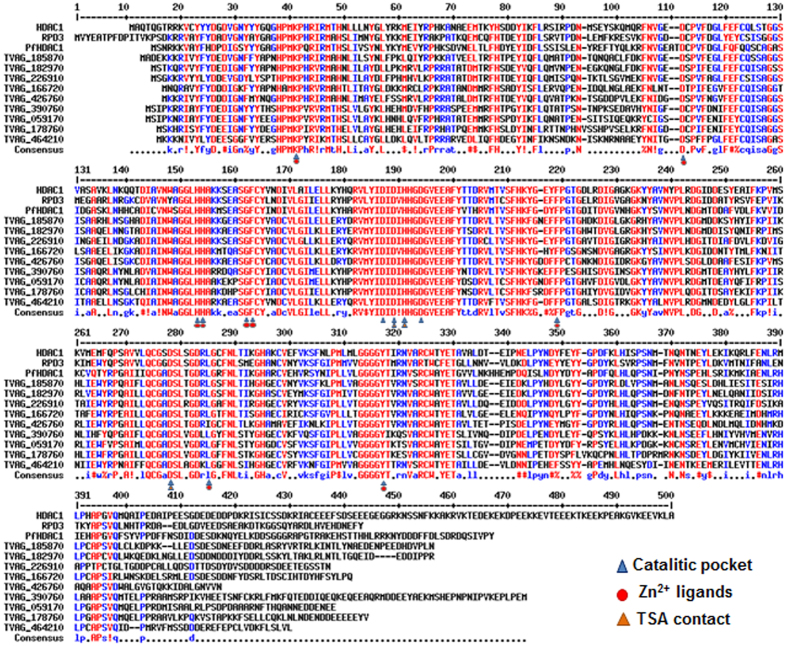
Histone deacetylase enzymes in T. vaginalis.Multiple protein sequence alignment of T. vaginalis HDACs with select orthologues. Indicated are residues important for catalytic activity and involved in zinc and TSA binding, based on the crystal structure of related HDACs2425. Alignments were performed with Multalin (http://bioinfo.genotoul.fr/multalin/). Gene bank accession numbers: human HDAC1 (NP_004955), Saccharomyces cerevisiae Rpd3 (AAB20328.1), and Plasmodium falciparum pfHDAC1 (XP_001352127.1).